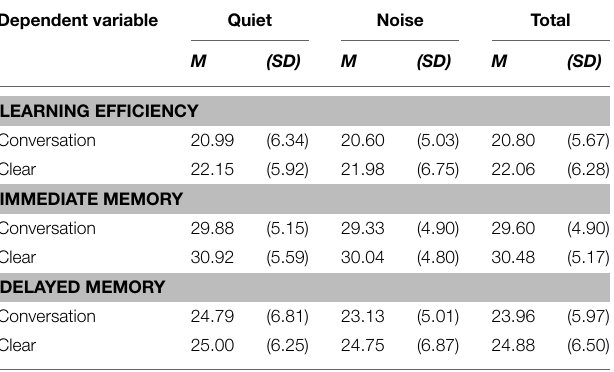
TABLE 6 | Quiet and Noise groups for Learning Efficiency, Immediate, and Delayed Memory performance in conversational and clear listening conditions.